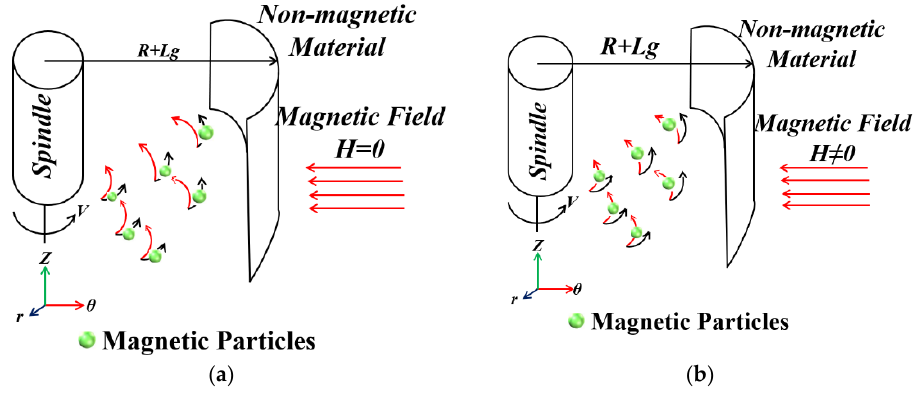
Figure 2. Shear motion of the MR fluid: ( a ) H = 0; ( b ) H ≠ 0.